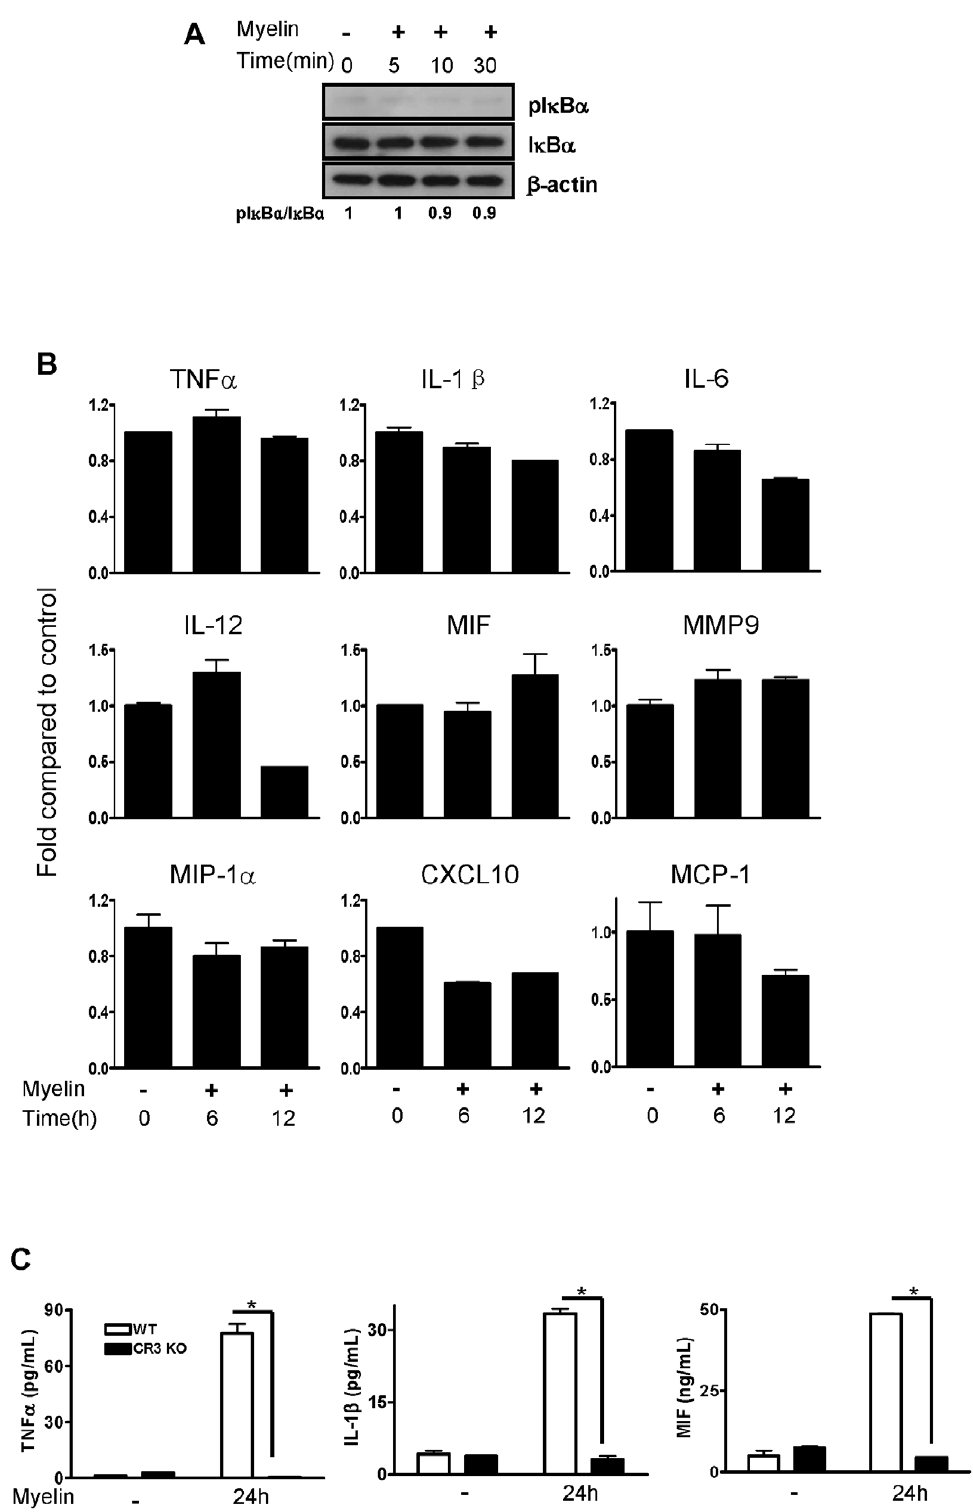
Figure 6. Effect of myelin on NF- k B activation and cytokine expression in bone marrow-derived macrophages from CR3 KO mice. (A) Macrophages from CR3 KO mice were treated with myelin for the indicated time and phosphorylation/degradation of I k B- a were assessed by western blot. (B) Macrophages from CR3 KO mice were treated with myelin for 6 and 12 hours. Cytokine and chemokine expression in cells at mRNA levels were detected by qRT-PCR. (C) Macrophages from WT and CR3 KO mice were treated with myelin for 24 hours and cytokines in the supernatants of cell culture were detected by ELISA. Phosphorylation levels were normalized to non-phosphorylated total proteins. Data were expressed as mean 6 SEM and similar results were obtained from three independent experiments. (n=3, *P , 0.05 vs. CR3 KO + myelin; t -test).